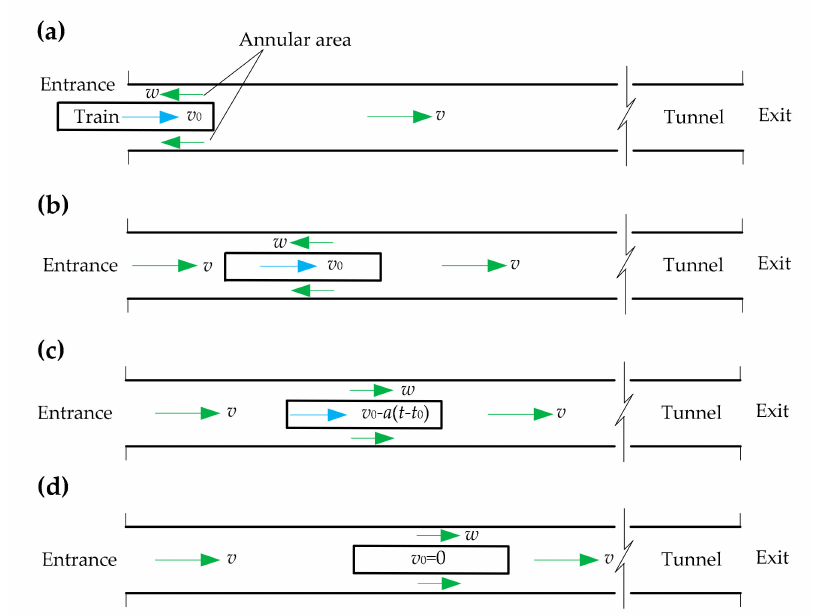
Figure 1. The process of a train urgently running to a rescue station. ( a ) Entering tunnel. ( b ) Uniform motion. ( c ) Uniformly decelerated motion. ( d )